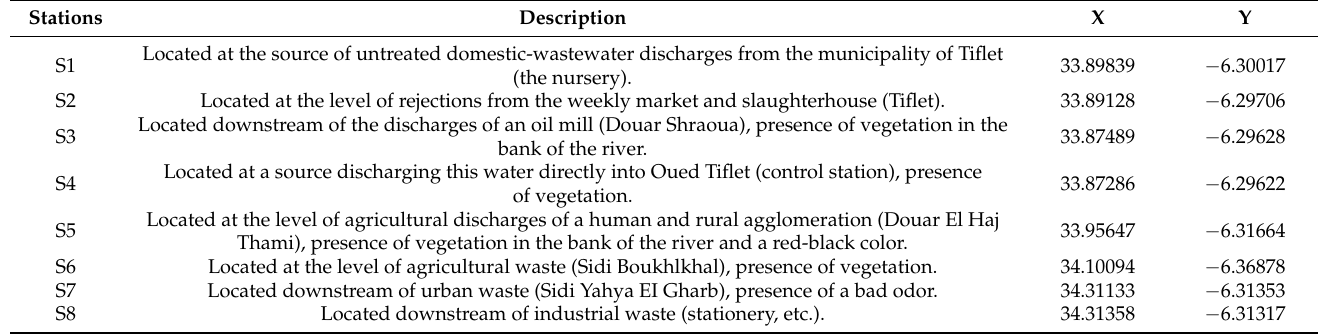
Table 1. Location of the water-quality monitoring stations, of the stream studied.